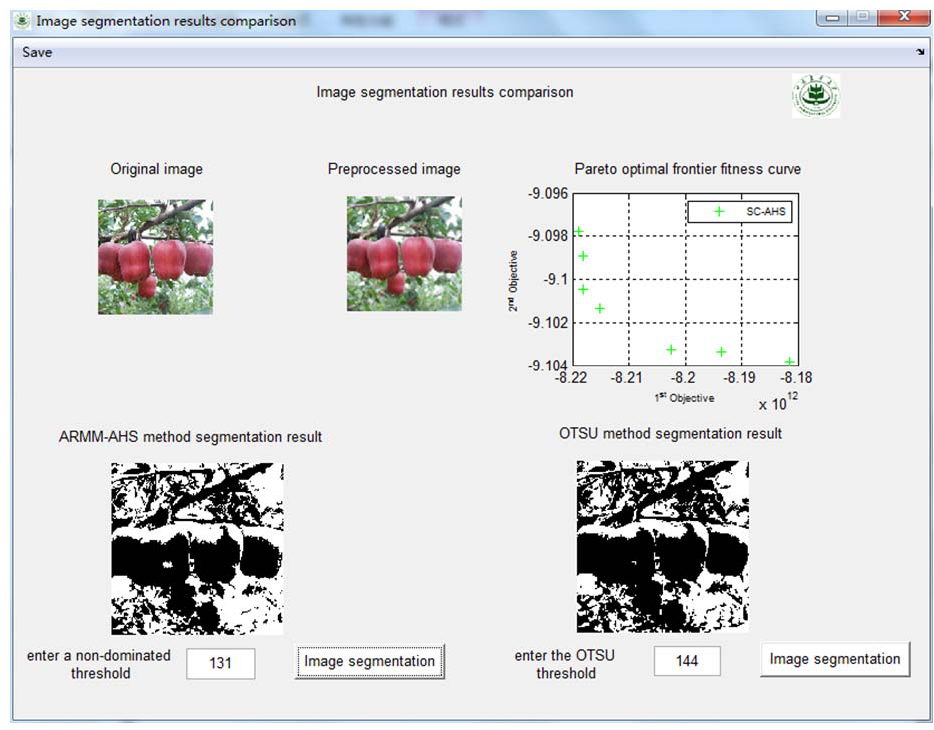
Figure 16. Comparison of the results of image segmentation under backlighting under the strong illumination condition.